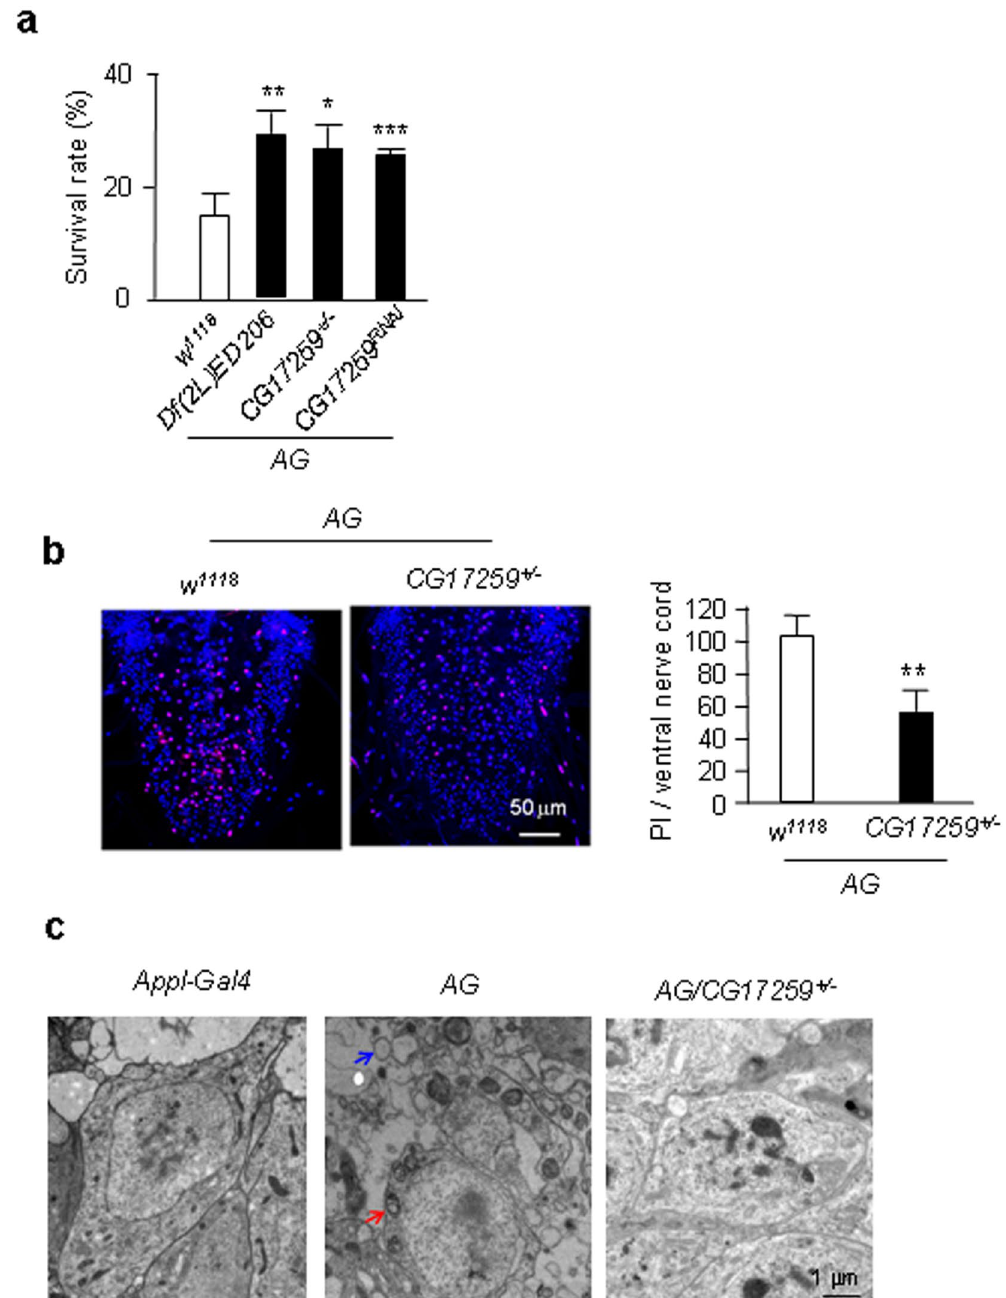
Figure 1. Deficiency screen indentifies a gene as a suppressor of neuronal necrosis. ( a ) Effect of LOF CG17259 on AG fly survival. Df(2 L)ED206 is a deletion mutant; CG17259 + / − represents the heterozygous mutant of CG17259 KG03126 and CG17259 RNAi represents the UAS-CG17259 RNAi fly. Trial n = 5. For all AG survival experiments, 60–150 flies were tested for each trial. Throughout all bar graphs, error bars are mean + standard deviation (s.d.); white bars represent control; gray bars represent no statistical difference; and black bars represent statistical significant difference from the control (ANOVA for group comparisons followed by post-hoc Tukey test; unpaired t -test for comparison of two data sets). Asterisk * for p < 0.05, ** for p < 0.01 and *** for p < 0.001. ( b ) Neuronal necrosis in AG flies determined by Propidium Iodide (PI) staining. The larval ventral nerve cord was stained with PI, and the statistic result is shown on the bar graph. 10 larvae were examined for each genotype. ( c ) The subcellular characteristic of AG fly brain. Representative images from the transmission electron microscope are shown, with the genotype of flies indicated on the micrograph. Red arrow points to a swollen mitochondria; and blue arrow points to a